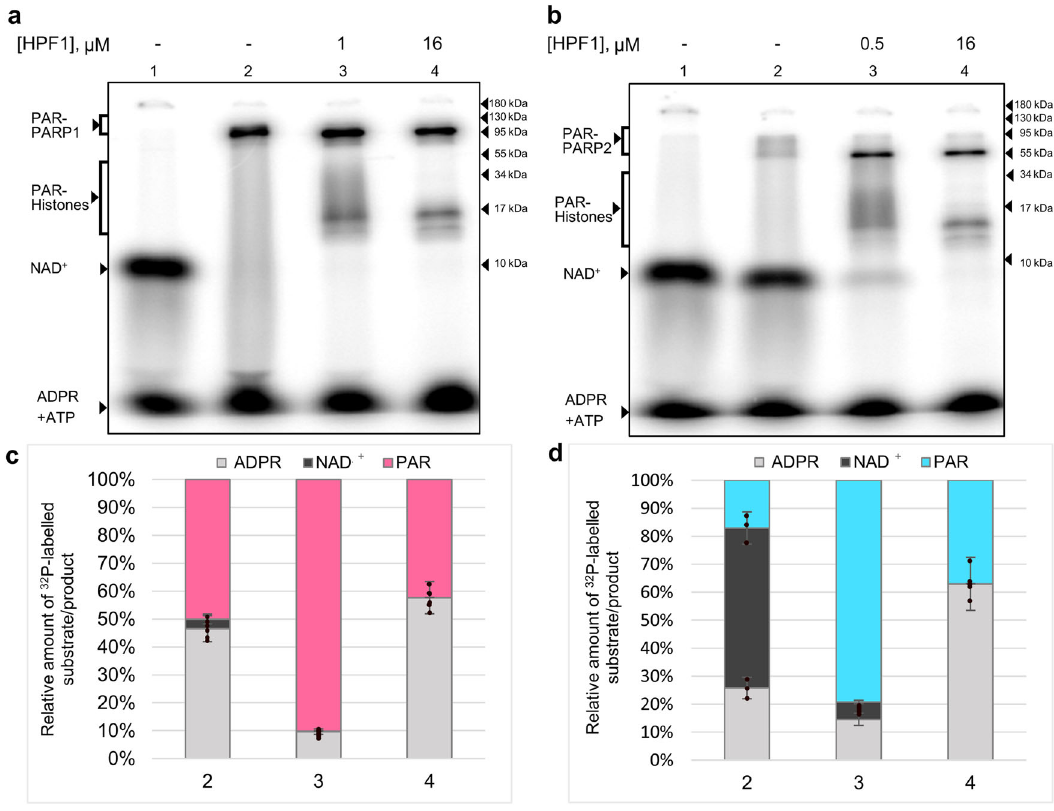
Fig. 6 The NAD + -hydrolase activity of PARPs is stimulated by the large excess of HPF1. a , b Autoradiograms of SDS-PAG after separation of ADP- ribosylated PARP1, PARP2, and histones from NAD + and free ADP-ribose (ADPR). The reaction catalyzed by PARP1/PARP2 (500 nM) in the presence of NCP (250 nM) and [ 32 P]NAD + (1 μ M) was performed in the absence or presence of HPF1 (1 and 0.5 μ M, PARP1 and PARP2 sample 3, and 16 µ M, sample 4). c , d Histograms present the relative amounts (%) of [ 32 P]NAD + and 32 P-labelled ADP-ribose covalently bound to PARPs and histones (PAR) and released in free form (ADPR) due to NAD + hydrolysis in the respective samples. The original [ 32 P]NAD + preparation (control sample 1 without PARP) was contaminated with ATP; its amount was subtracted from the amount of free ADP-ribose (comigrated with ATP) in samples 2 ‒